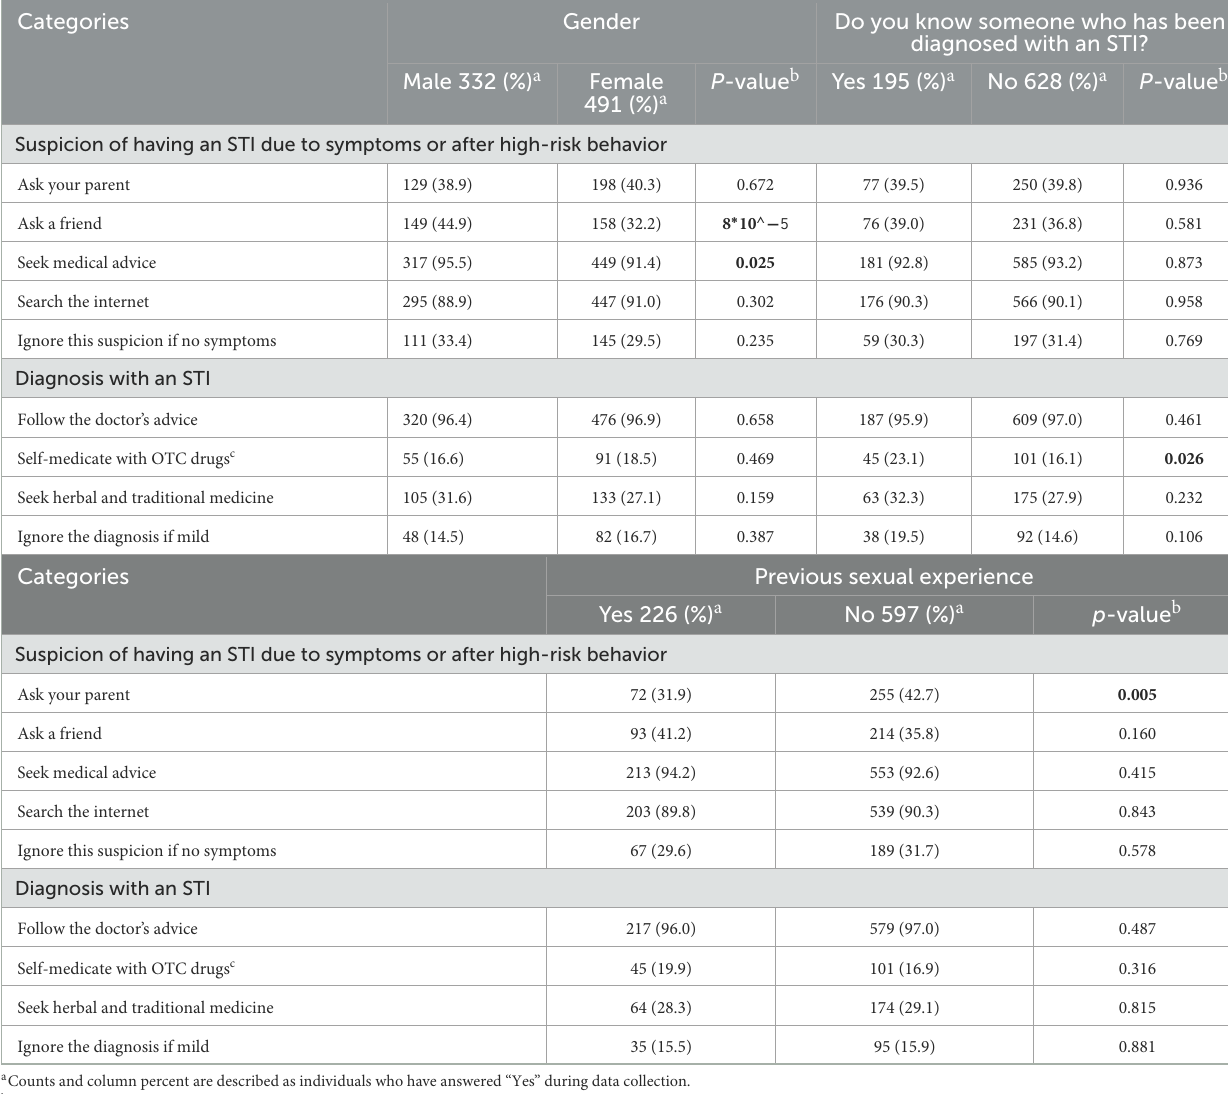
TABLE 4 Practices upon suspicion or diagnosis with a sexually transmitted infection among non-medical undergraduates in Baghdad,